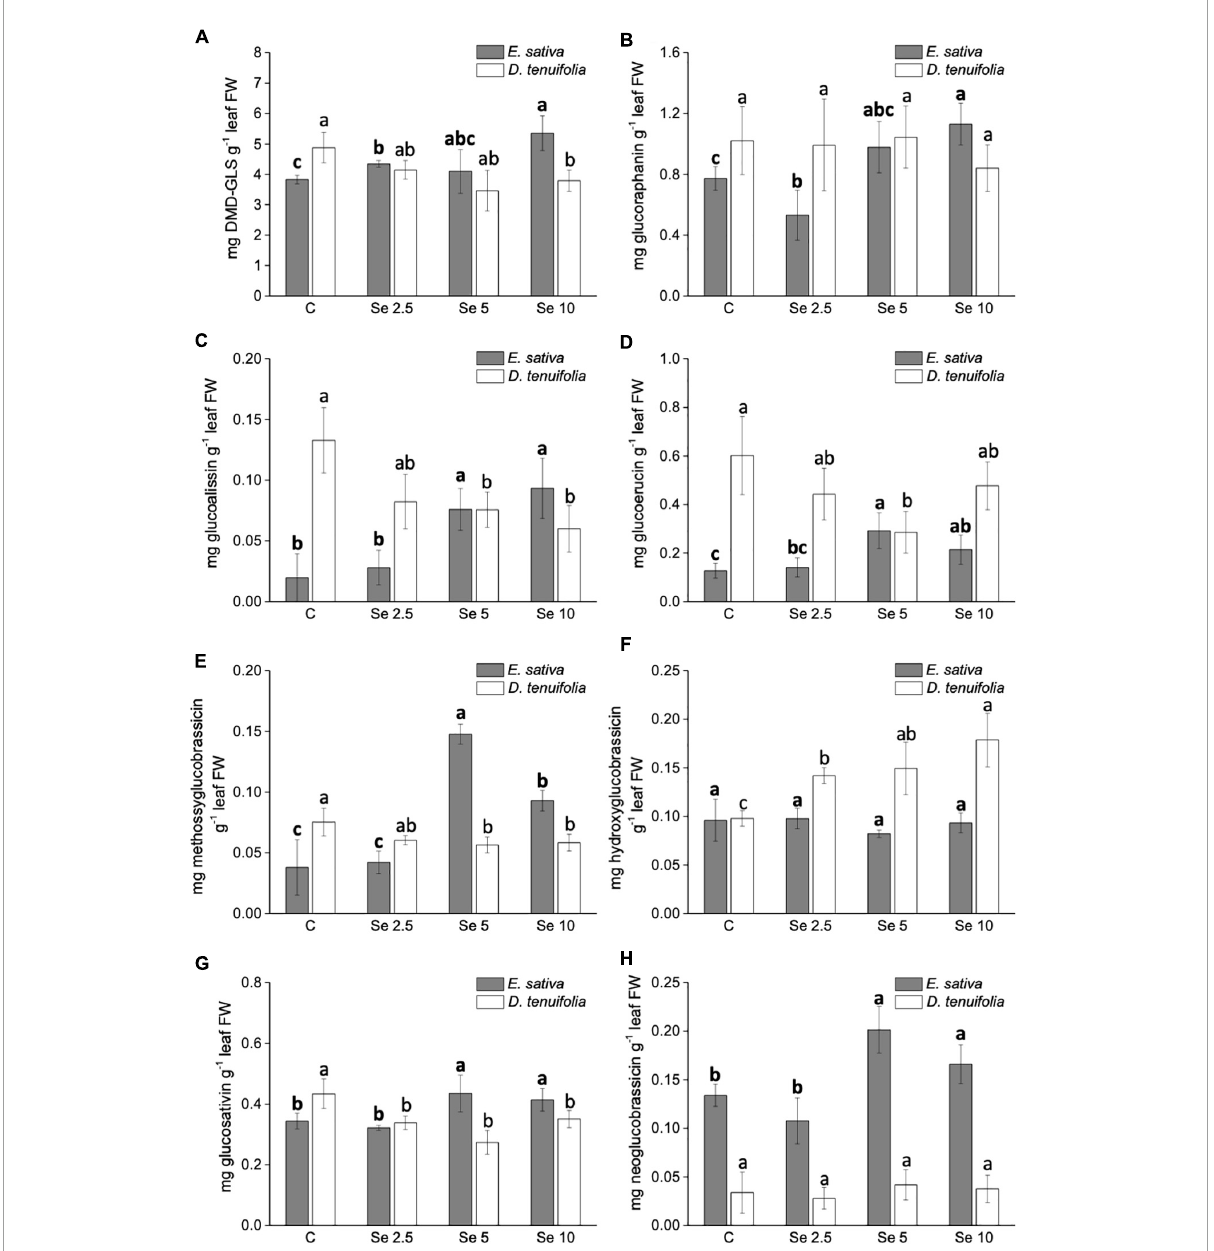
FIGURE5 Effects of selenate treatment on the content of individual glucosinolates, i.e., DMD-GLS (A) , glucoraphanin (B) , glucoalissin (C) , glucoerucin (D) , methossiglucobrassicin (E) , hydroxyglucobrassicin (F) , glucosativin (G) , and neoglucobrassicin (H) , identified in Eruca sativa and Diplotaxis tenuifolia plants grown in soil and subjected to foliar fertilization with selenate dosages ranging from 0 to 10 mg per plant. Data shown are the mean ± SD of three replicates. Different letters in bold above bars indicate significant differences between the means ( p < 0.05) of values referred to E. sativa , while different letters not bolded indicate significant differences between the means ( p < 0.05) of values referred to D. tenuifolia . DBM-GLS = Dimeric-4-mercaptobutyl glucosinolate.